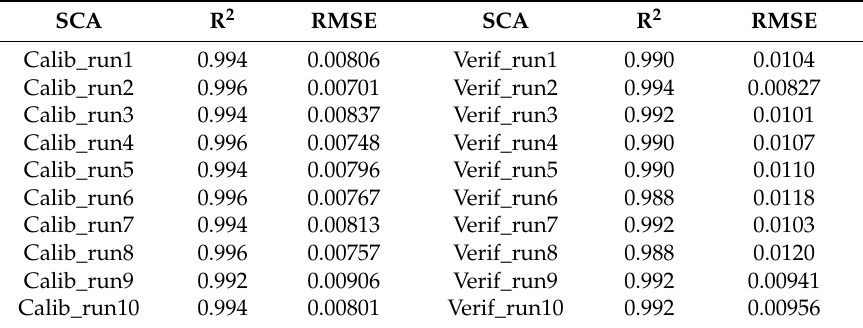
Table 3. R 2 and RMSE through SCA methods through 10 experimental runs.